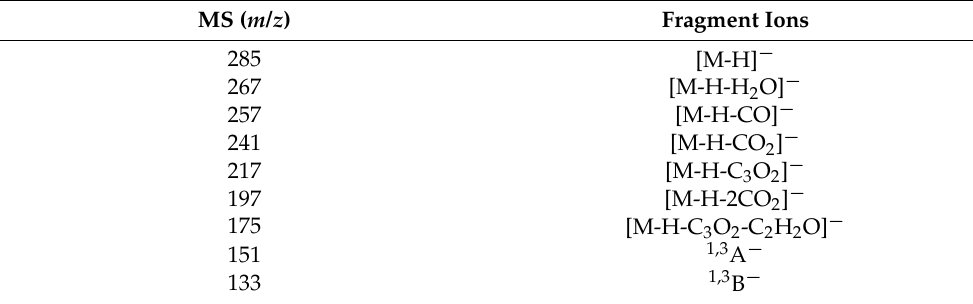
Figure 2. ESI-MS spectrum of luteolin acquired in negative ion mode. Table 1. ESI-MS product ions obtained for luteolin.